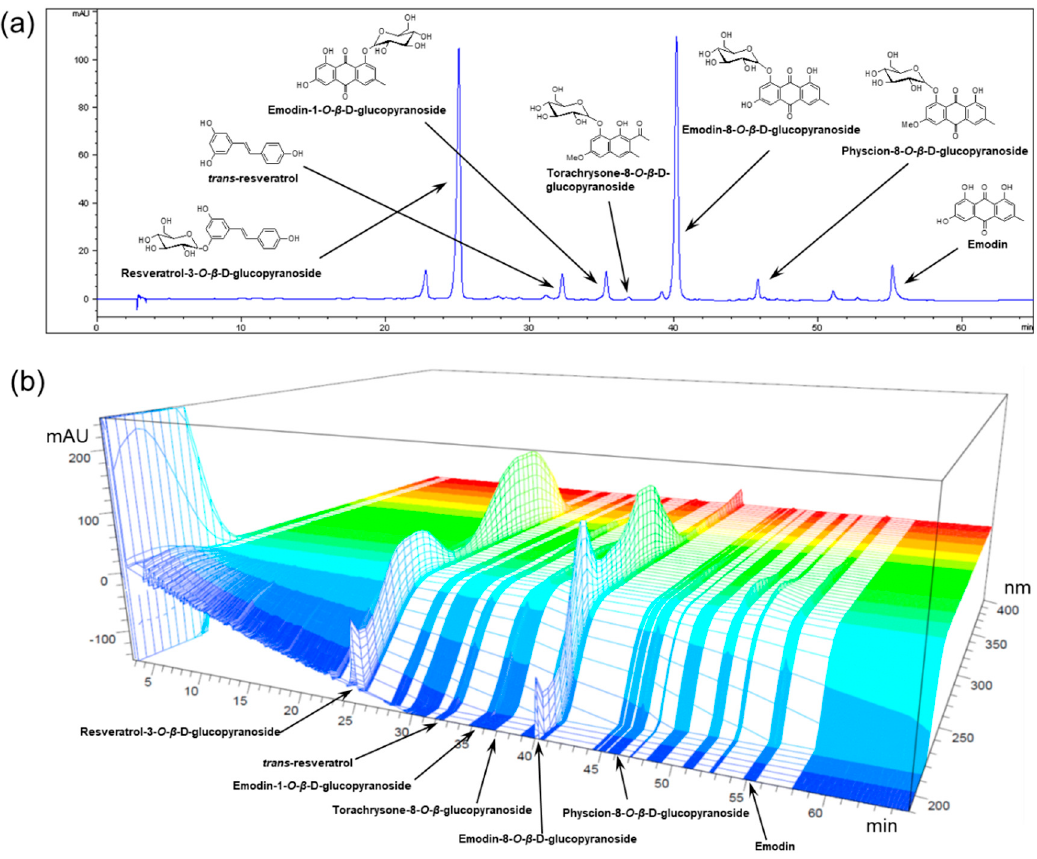
Figure 1. HPLC chromatograms of POCU1b. ( a ) One-dimensional (290 nm) and ( b ) three-dimensional (200–400 nm) HPLC chromatograms of POCU1b. Table 1. Contents of marker compounds in POCU1b.